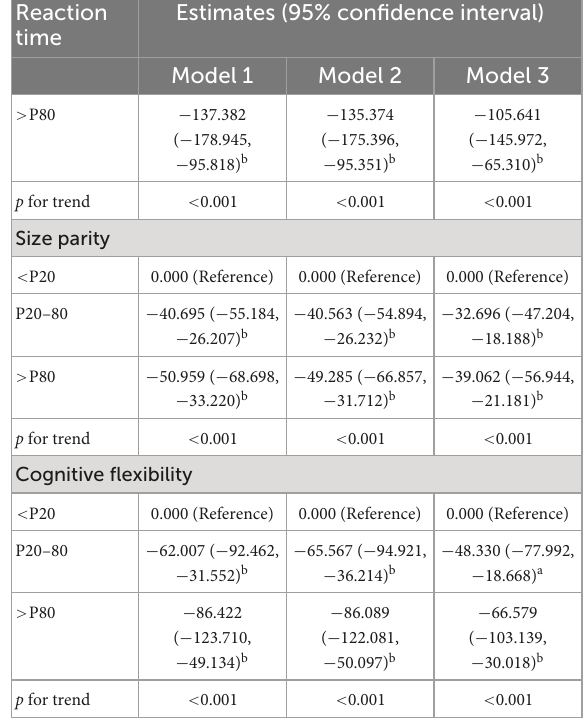
TABLE 3 Multiple linear regression analysis of muscle strength index and executive function in children and adolescents in rural areas of China ( n =